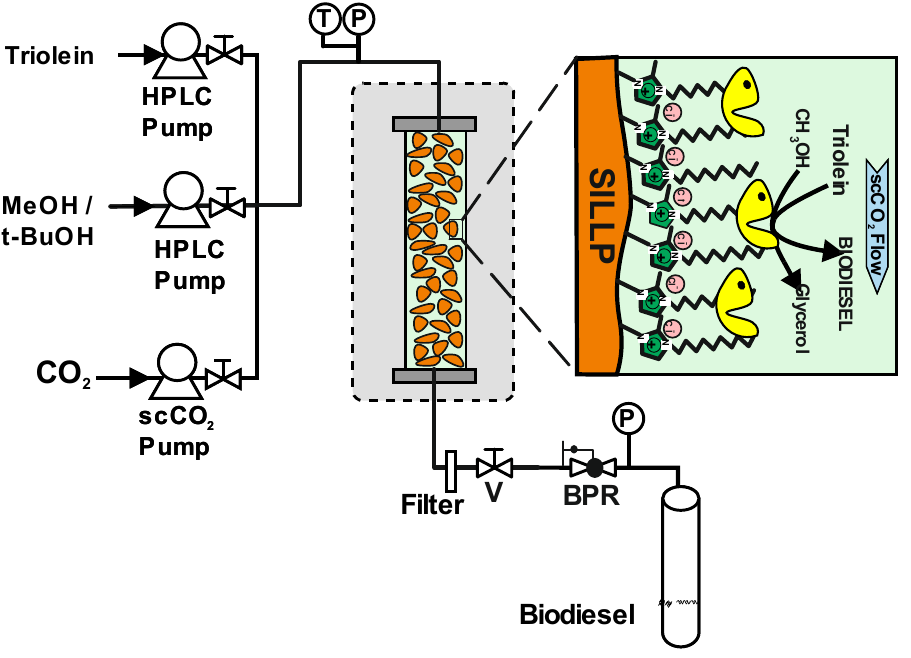
Figure 8. Set-up of a continuous reactor containing immobilized lipase onto Supported Ionic Liquid-Like Phases (SILLPs) for biodiesel synthesis by methanolysis of triolein [93]. T, Temperature indicator; P, pressure indicator; V, valve; BPR, Back-pressure